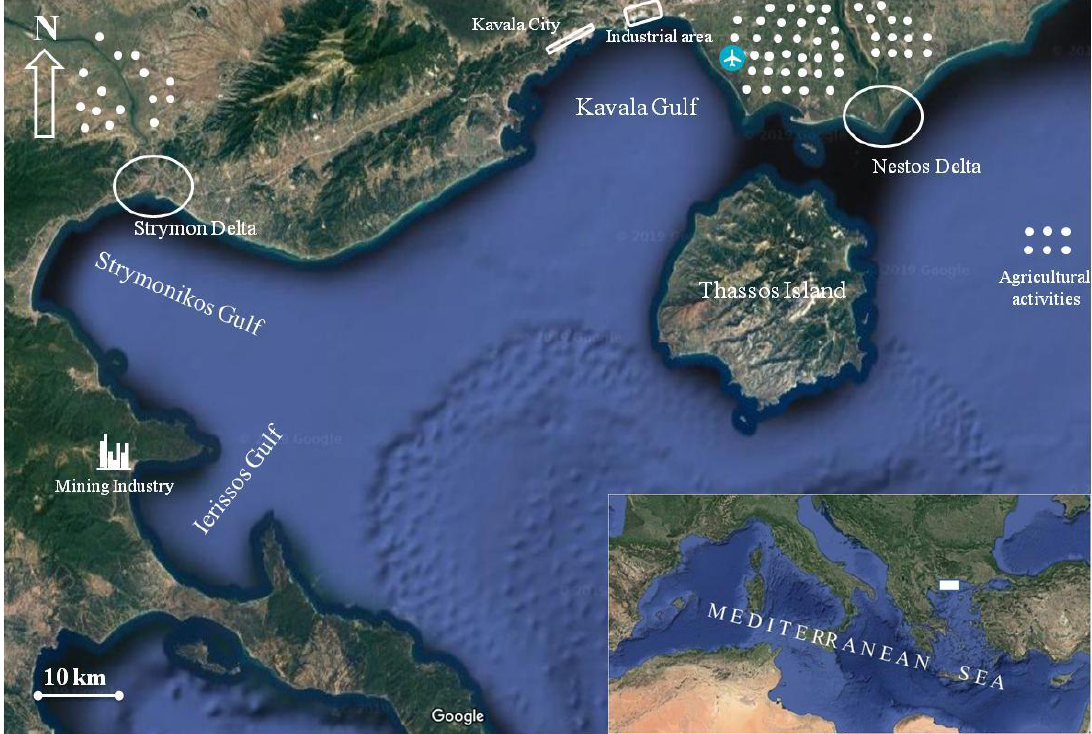
Figure 1. Map of main terrestrial activities in the watersheds of the three gulfs at northern Aegean Sea: Kavala Gulf; Strymonikos Gulf and Ierissos Gulf.